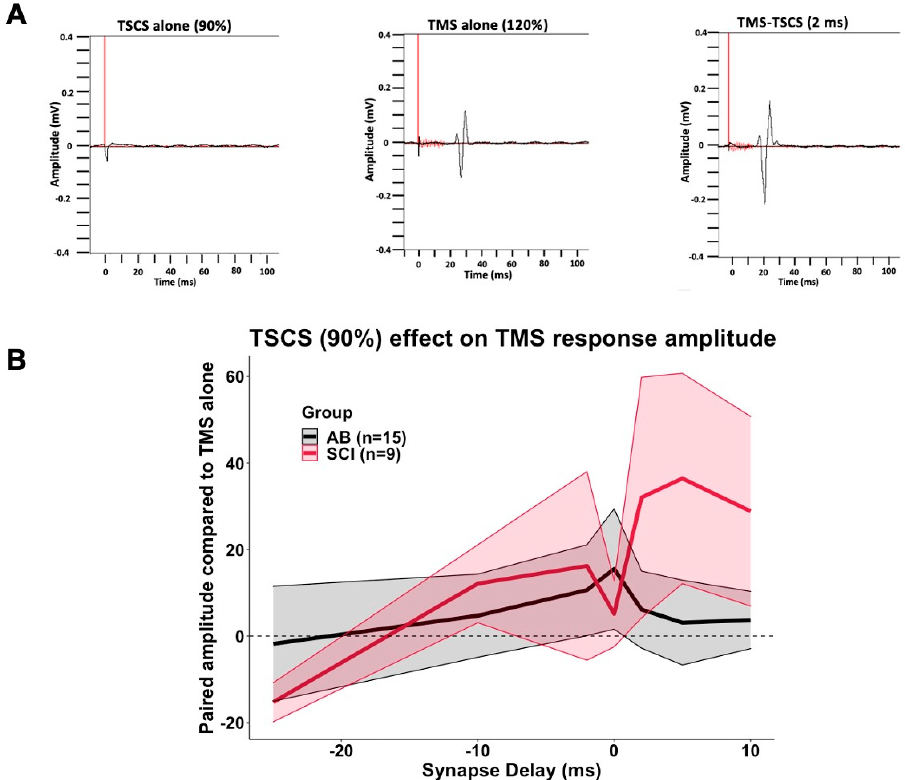
Figure 2. Subthreshold TSCS acutely facilitates TMS-evoked potentials. Suprathreshold (120%) TMS and subthreshold TSCS were given alone or in combination as depicted in Table 1. Response amplitudes were compared to the response to TMS alone (0). Synapse delay represents the time of TSCS pulse arrival at cervical motor neurons relative to test pulse arrival. Negative numbers indicate TSCS pulse arrival before test pulse arrival. ( A ). Representative waves from participant #29. ( B ). Effect of conditioning TSCS at 90% RMT. Black line (grey shading) indicates mean (SEM) for AB participants. Red line (pink shading) indicates mean (SEM) for SCI participants. Table 4. TMS responses to conditioning TSCS